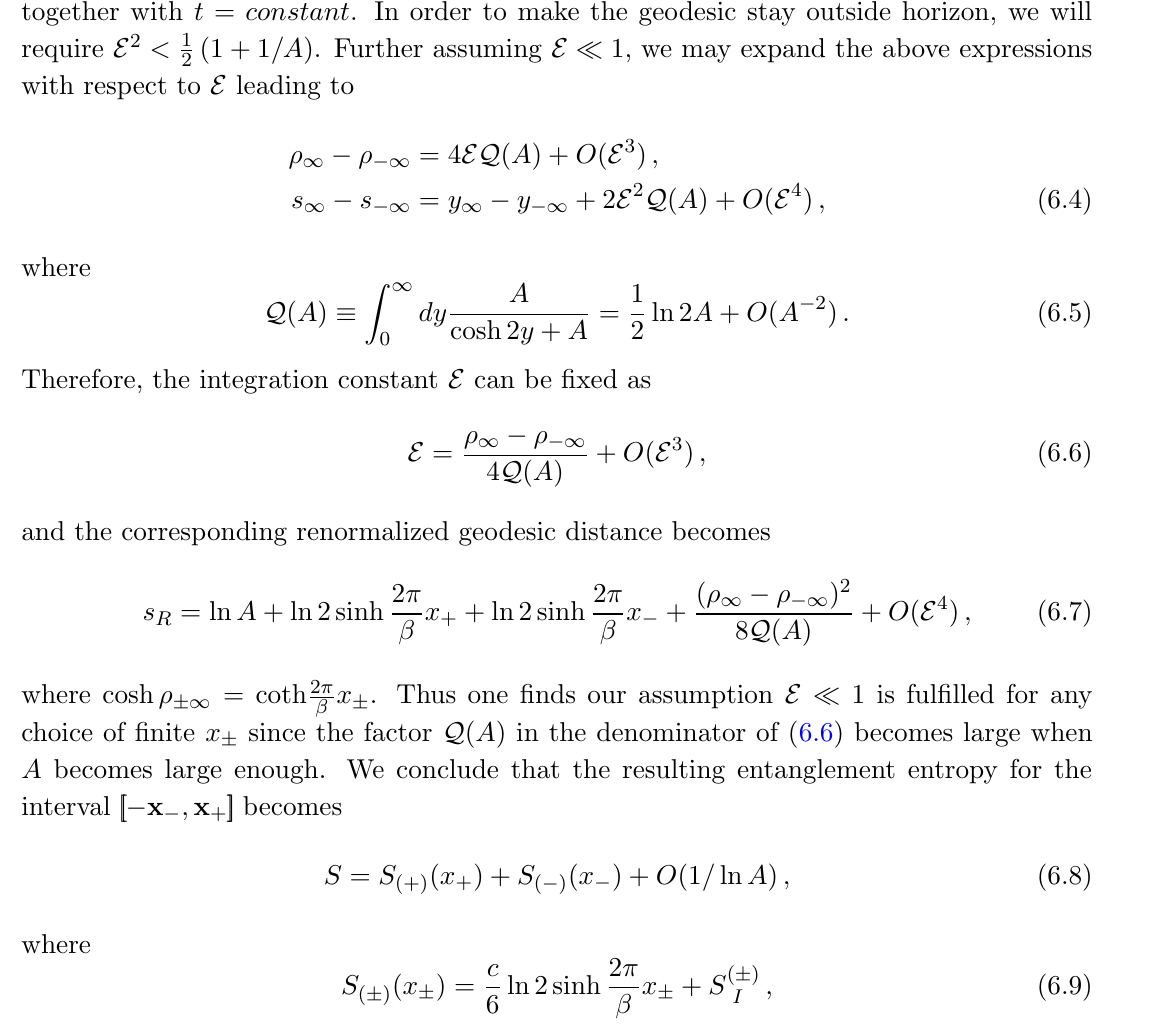
(cid:22) I surfaces at ( w (cid:6) ; t ) (cid:6)